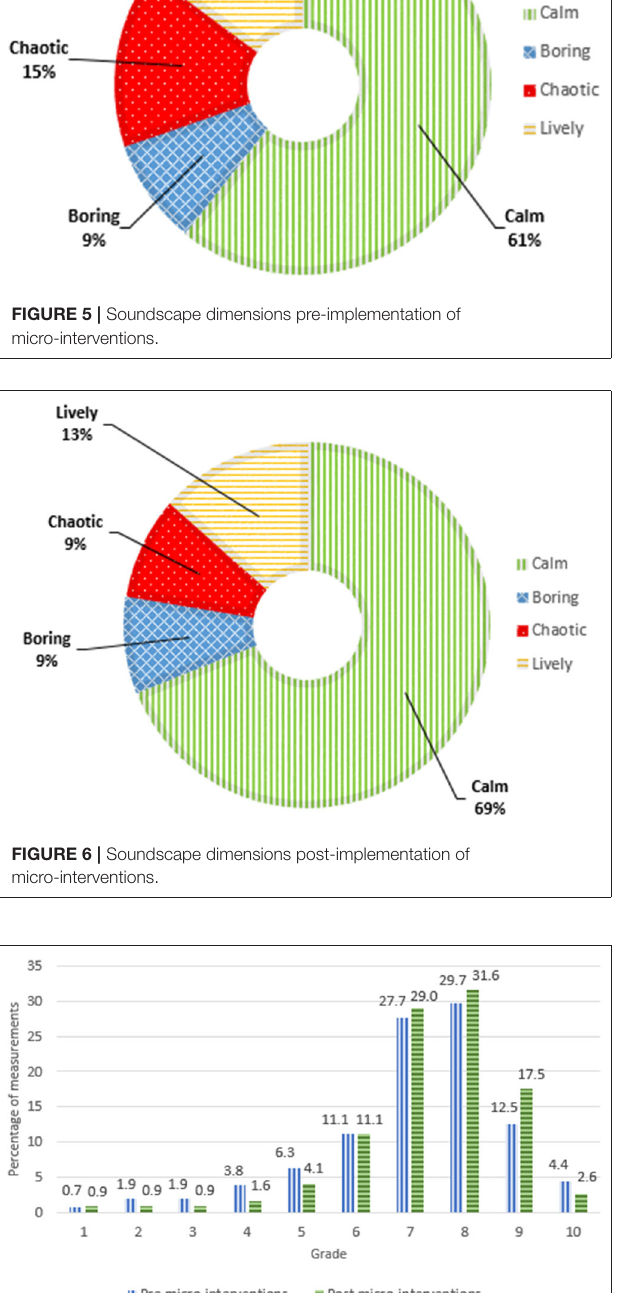
implementation of the micro-interventions, and this change was statistically significant (z = 15.3, p < 0.01).